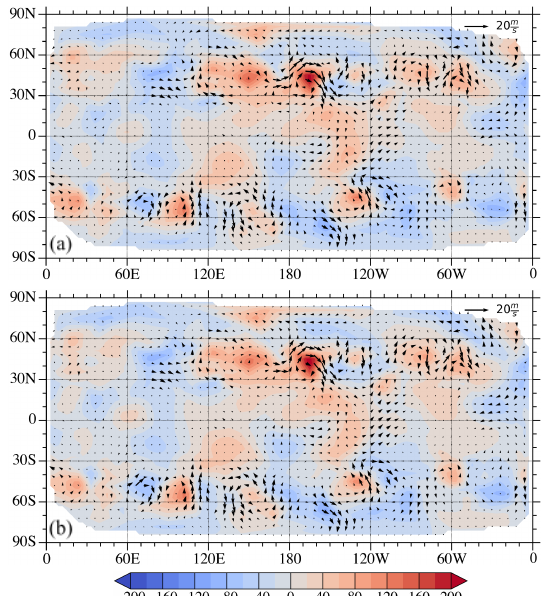
Figure 4. The differences in height (shaded) and wind (vectors) between the 12-h forecasts by Fig. 4: The differences in height (shaded) and wind (vectors) between the 12-hour forecasts by (a) NN-based SW and (b) MPAS-SW with respect to the initial conditions. ( a ) NN-based SW and ( b ) MPAS-SW with respect to the initial